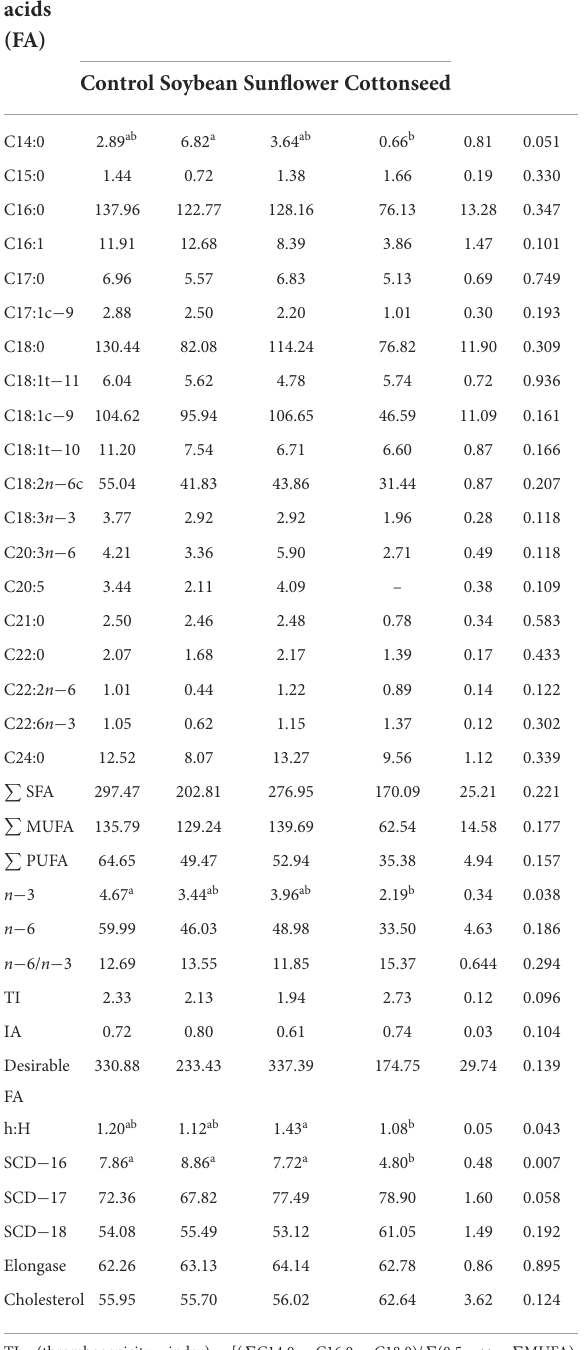
TABLE 5 Fatty acid composition and cholesterol content (mg 100 g − 1 of muscle) of burger of the steers fed different oilseeds grains.